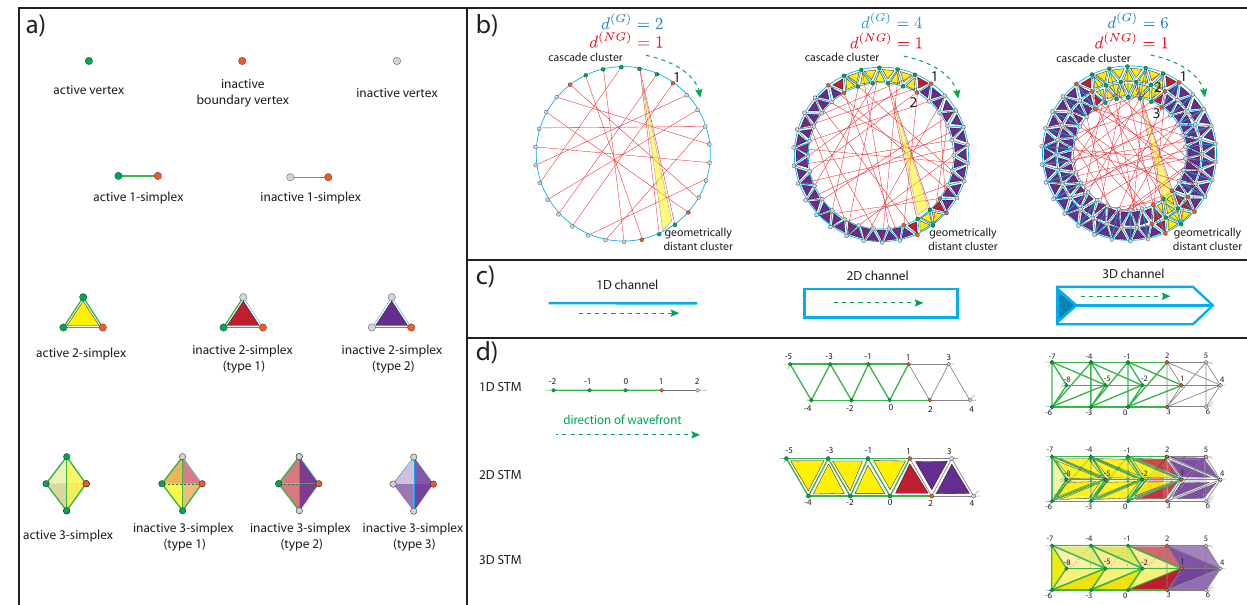
Fig. 2 Wavefront propagation for κ -dimensional simplicial threshold model cascades on noisy ring complexes. a Each k -simplex with k ≤ κ is given a binary state x k ð t Þ 2 f 0 ; 1 g indicating whether it is inactive or active, respectively, at time t = 0, 1, 2, … . Cascade propagation occurs when an inactive i boundary vertex is adjacent to suf fi ciently many active k -simplices, in which case it (and possibly some of its adjacent k -simplex neighbors) will become active upon the next time step. There are different types of inactive k -simplices, depending on how many of their vertices are active. b Noisy ring complexes (see Methods section “ Generative model for noisy ring complexes ” ) generalize noisy ring lattices 22 and contain vertices that lie on a 1D ring manifold that is embedded in a 2D “ ambient ” space. Each vertex has d ( NG ) = 1 non-geometric edge (red lines) to a distant vertex and d ( G ) geometric edges (blue lines) to nearby vertices with d ( G ) ∈ {2, 4, 6} (left, middle, and right columns, respectively). Higher-dimensional simplices arise in the associated clique complexes and are similarly classi fi ed as geometric/non-geometric. To simplify our illustrations, we place vertices alongside the manifold when d ( G ) > 2, and we do not visualize 3-simplices. c Geometric k -simplices with k ≤ K compose a K -dimensional geometrical substrate. For noisy ring complexes, K = d ( G ) /2 and the substrate is a K -dimensional channel — which is a non-intersecting sequence of lower-adjacent K -simplices. Channels generalize